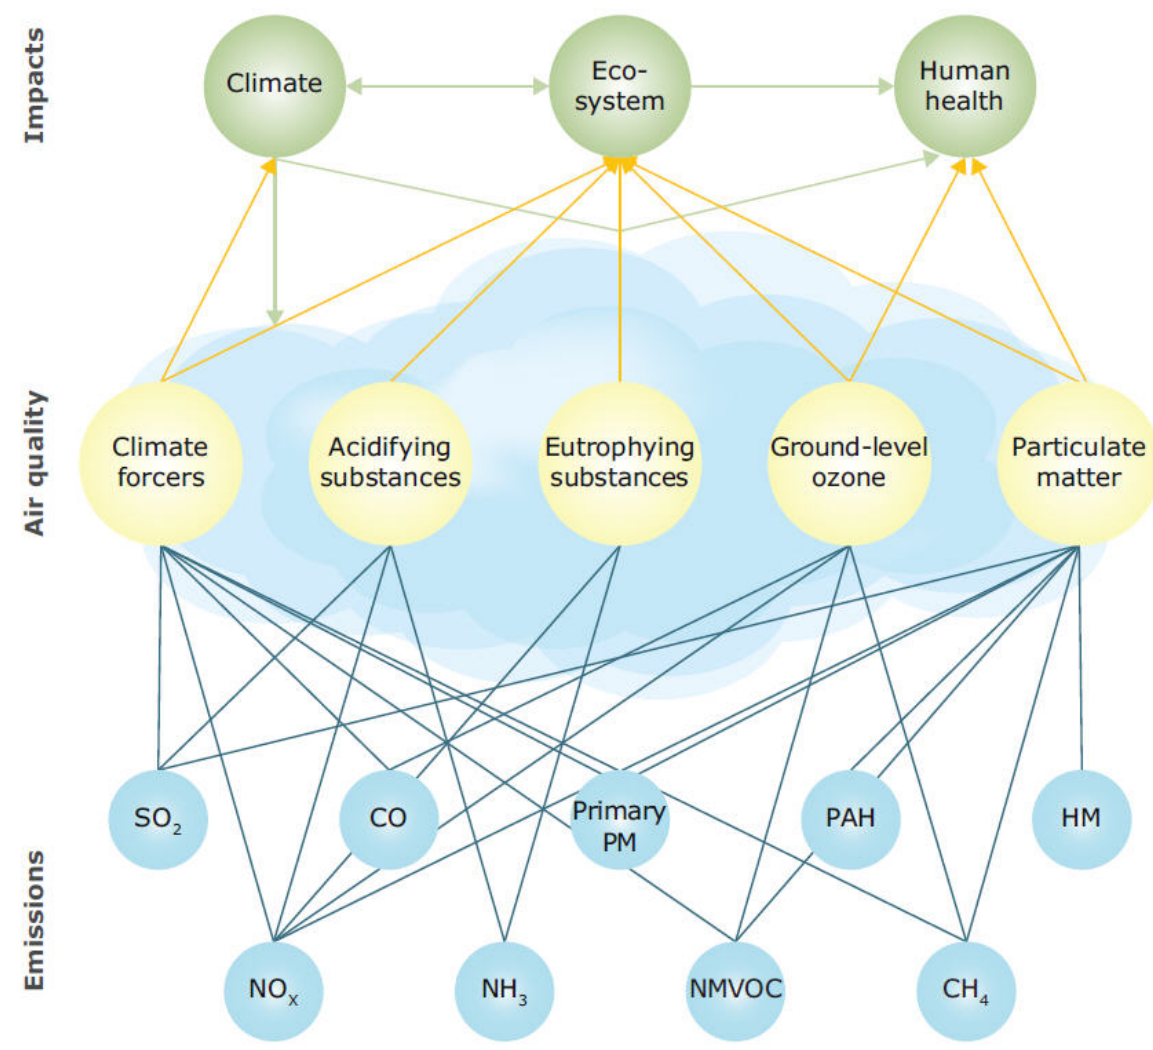
Figure 1. Major air pollutants in Europe, clustered according to impacts on human health, ecosystems, and climate [32]. Pollutants, from left to right: sulfur dioxide (SO 2 ), nitrogen oxides (NO x ), carbon monoxide (CO), ammonia (NH 3 ), particulate matter (PM), non-methane volatile organic compounds (NMVOC), polycyclic aromatic hydrocarbons (PAH), methane (CH 4 ), heavy metals